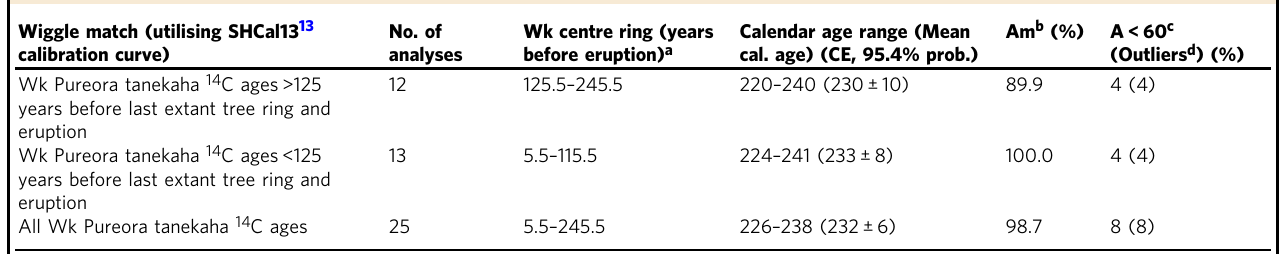
Table 1 Impact on the Taupo eruption date estimate Wiggle match (utilising SHCal13 13 calibration